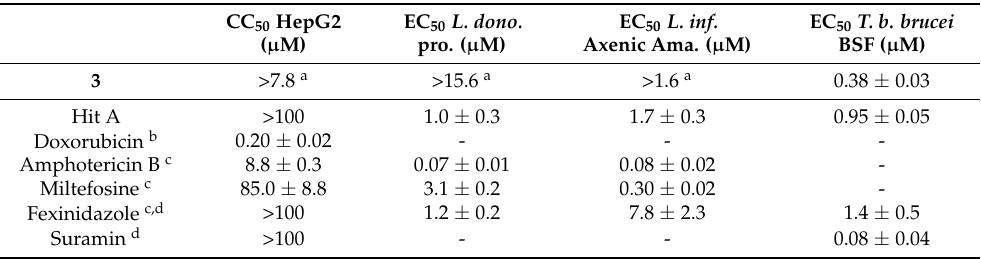
Table 2. In vitro evaluation of molecule 3 on L. donovani promastigotes, L. infantum axenic amastigotes, T. b. brucei trypomastigotes (BSF) and the human hepatocyte HepG2 line.